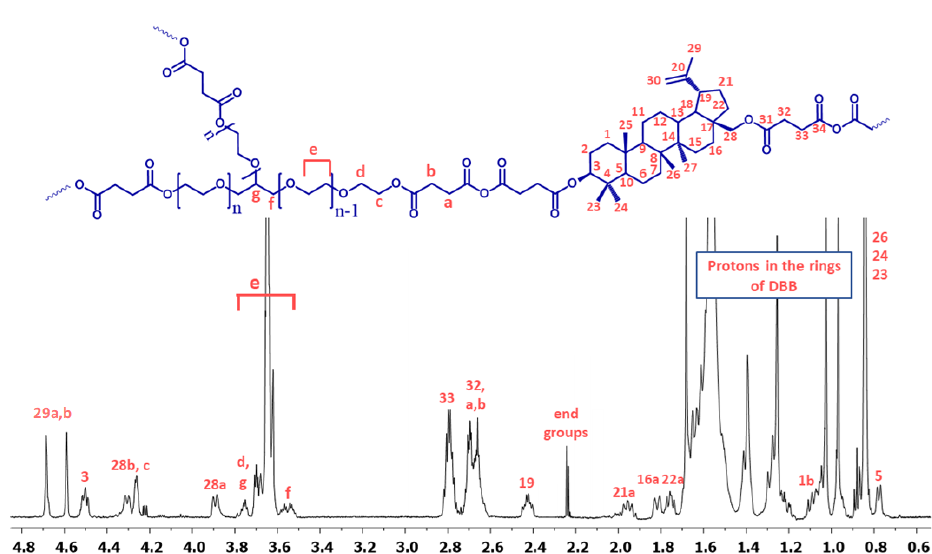
Figure 5. 1 H NMR spectrum of polyanhydrides based on betulin disuccinate and PEG(COOH) 3 .